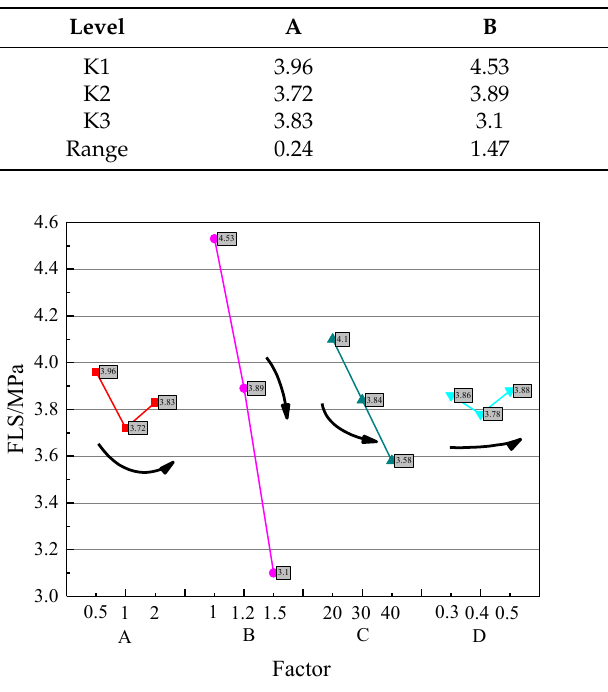
Figure 7. Trend chart of the influence of various factors on FLS.